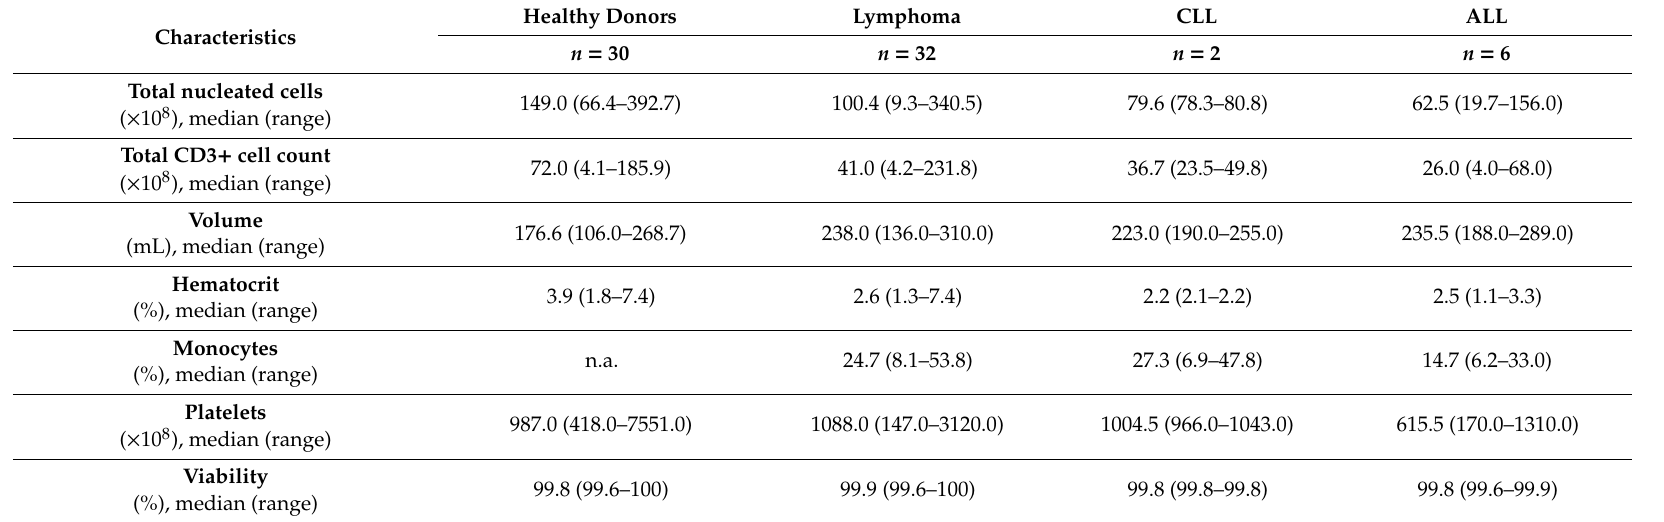
Table 4. Leukapheresis product